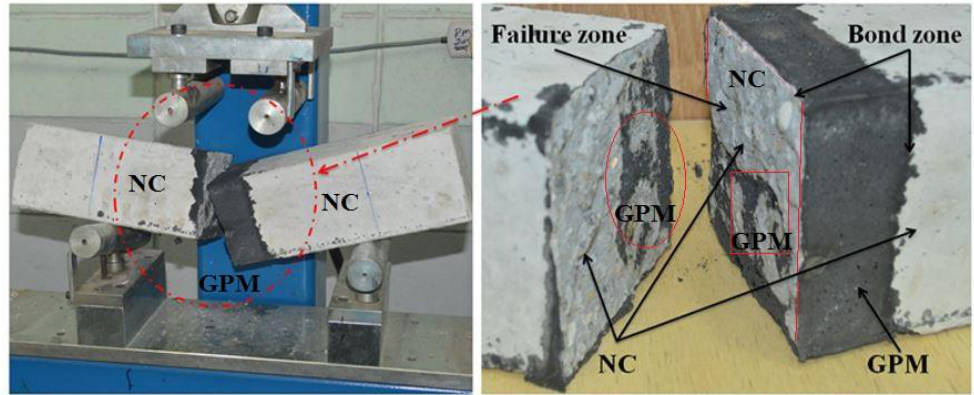
Figure 13. Failure pattern of GPMs made with 50% WCT under the four points flexural strength test.